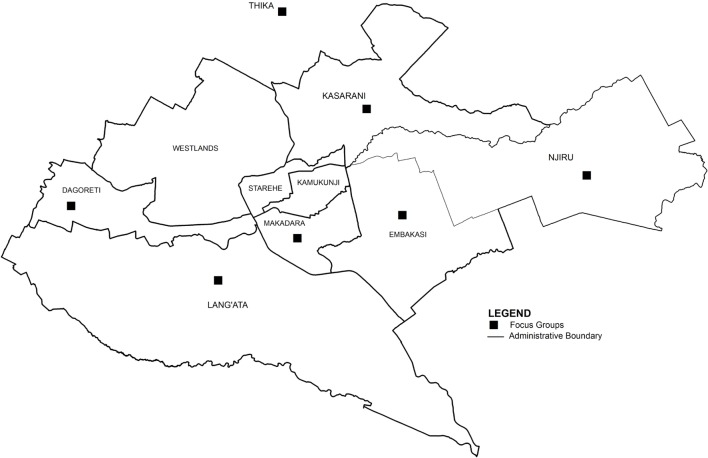
Division of former sub-counties in Nairobi, and indication of sub-counties where focus group discussions with livestock production officers were conducted.